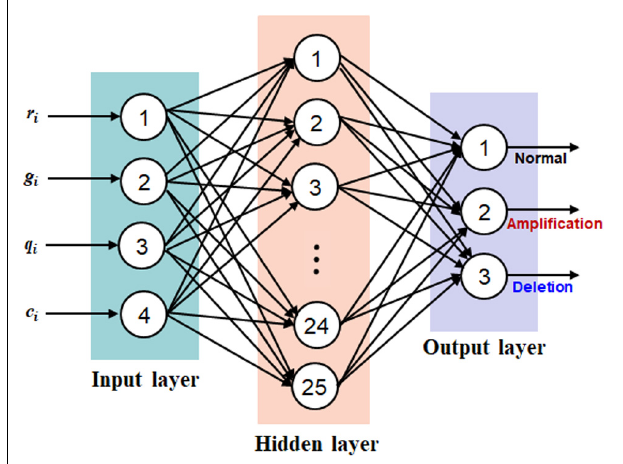
FIGURE 2 | The topology of the back-propagation neural network, which includes three layers: input layer with four neurons, hidden layer with 25 neurons, and output layer with three